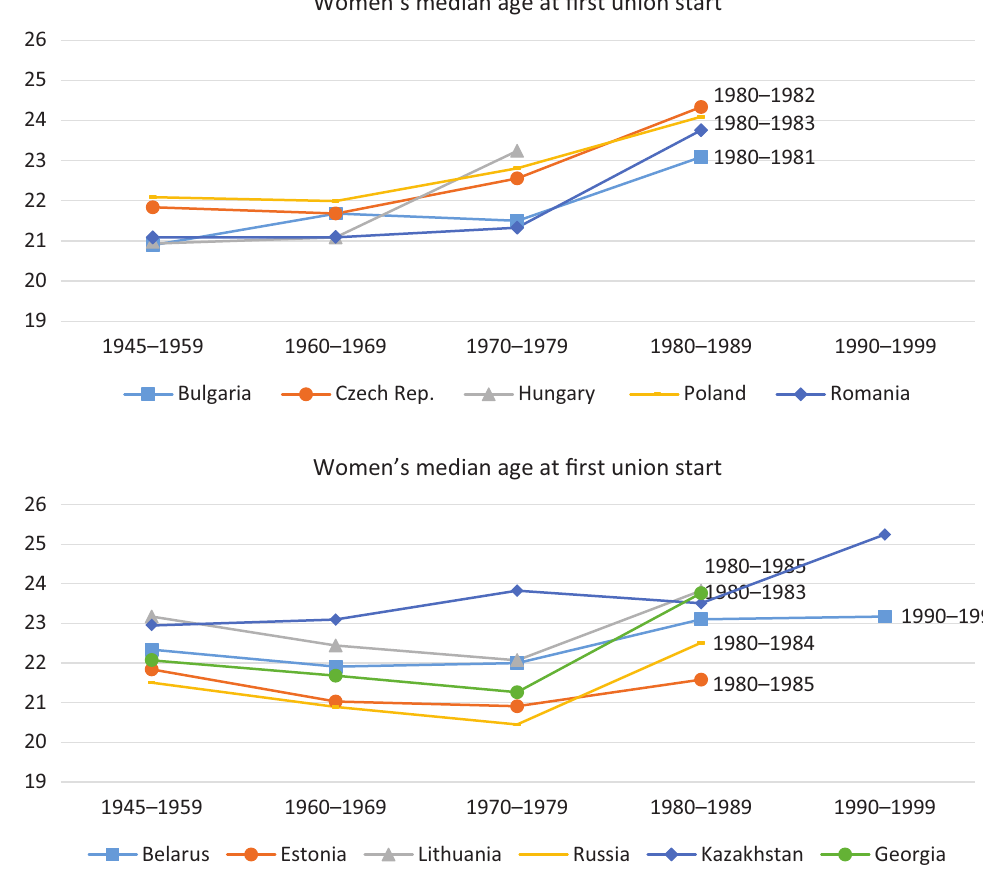
Figure 1. Women’s median age at the start of a first co‐residential union, by country and birth cohort. Notes: Given the survey year and the degree of partnership postponement, not all birth cohorts could be included in the analysis; no final cohorts are specifically indicated for Hungary and Poland in the top panel and Kazakhstan in the lower panel because the cohorts follow the